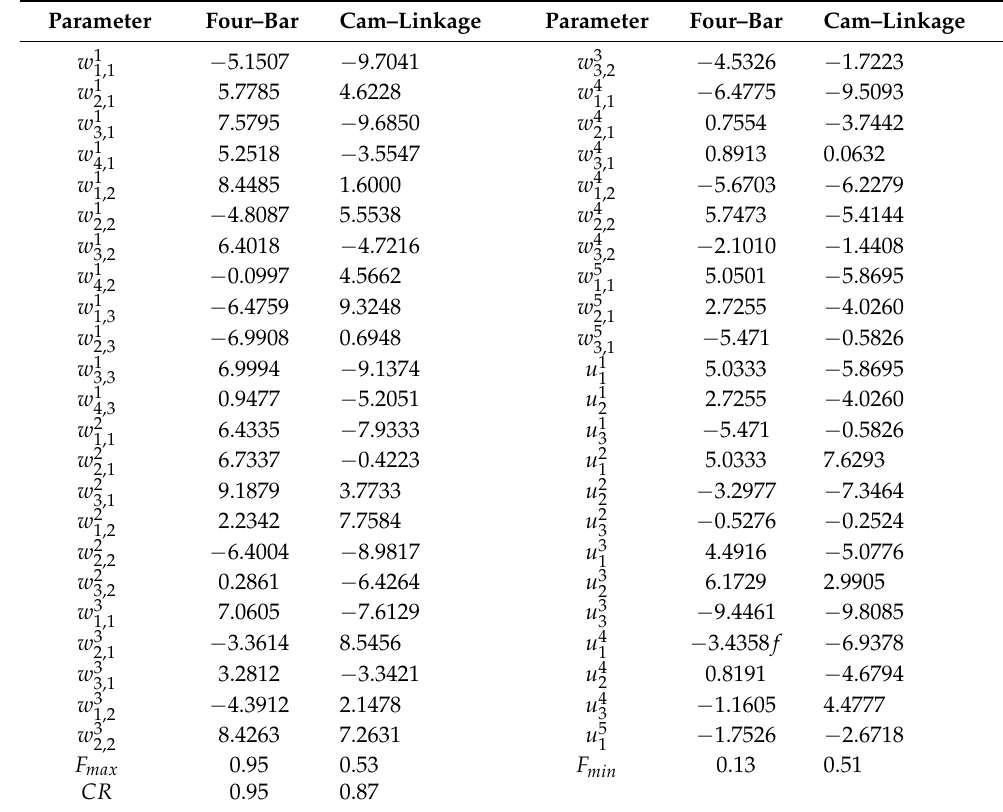
Table 4. Algorithm parameters of the NCH obtained by the irace